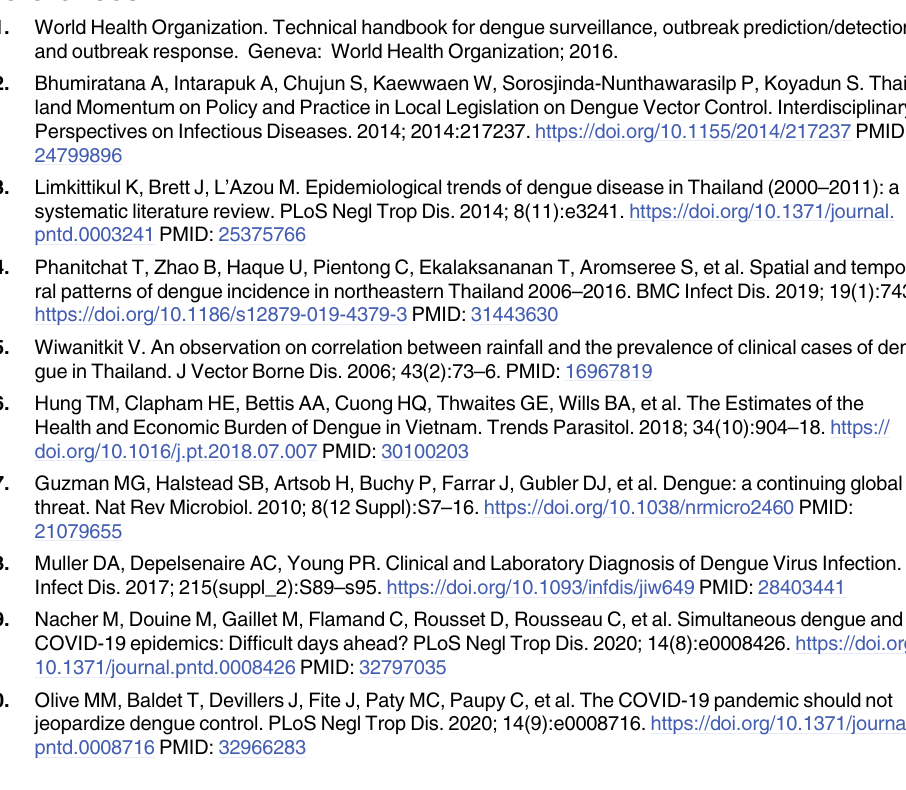
S15 Table. Societal impact of dengue.